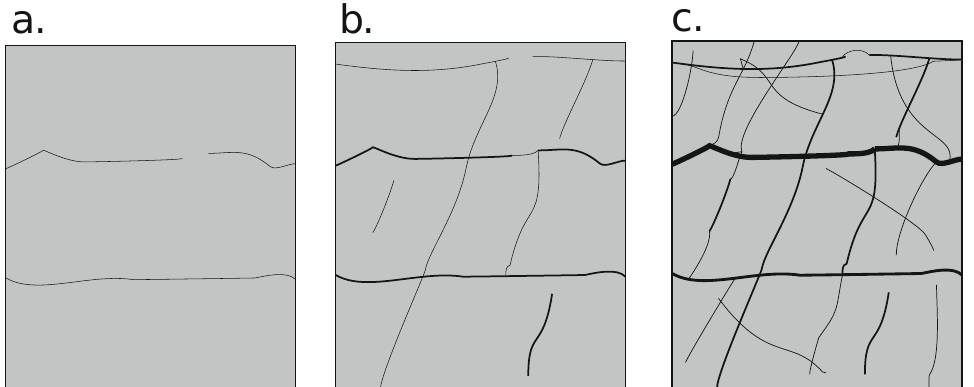
Figure 2. Propagation of fractures along with stress increase ( a ) fracture initiation, ( b ) fracture development, ( c ) fracture expansion.